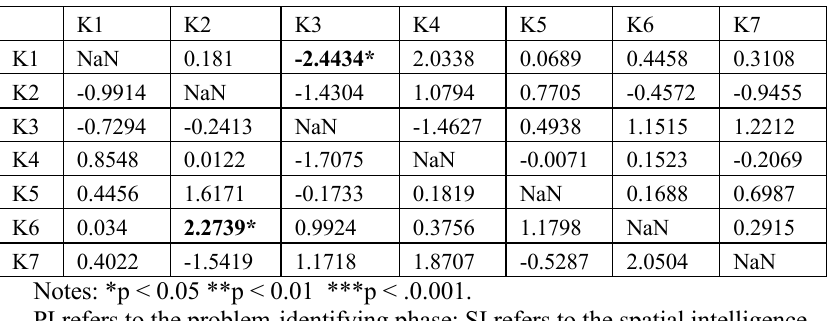
Two-sample t test during PI in the SI